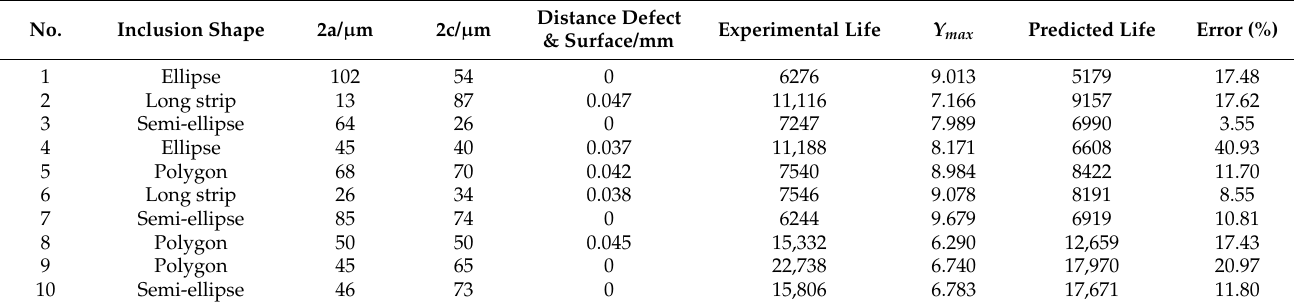
Table 10. Life prediction of specimens containing inclusion.